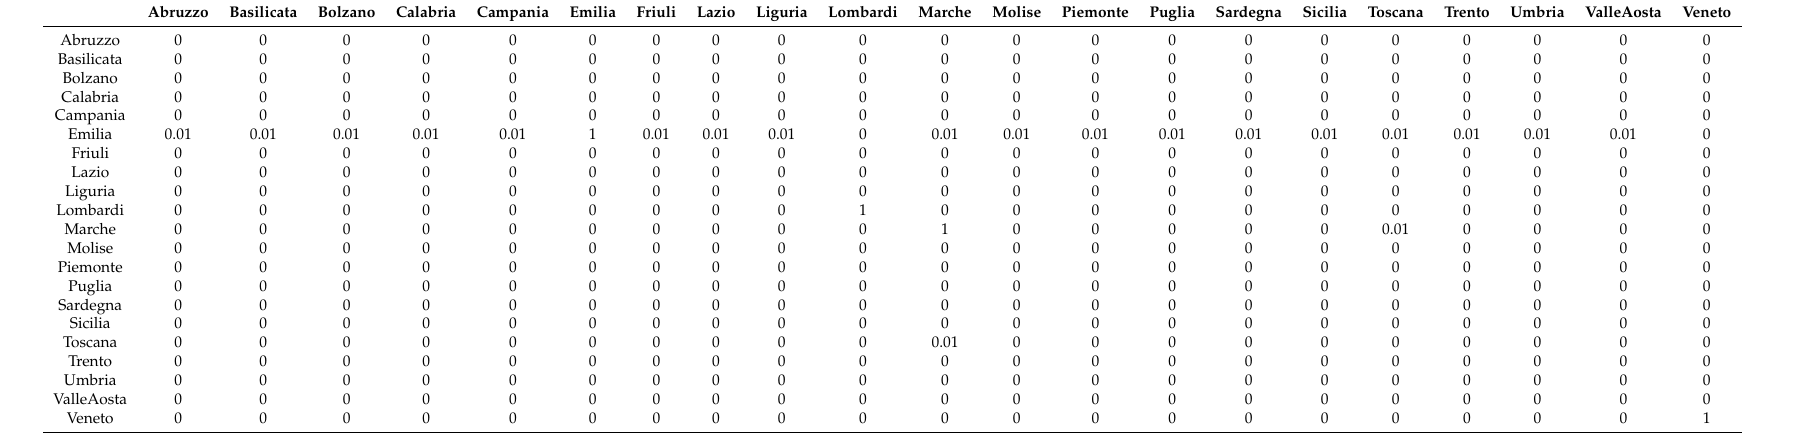
Table A44. Similarity values of Deceased network in the first